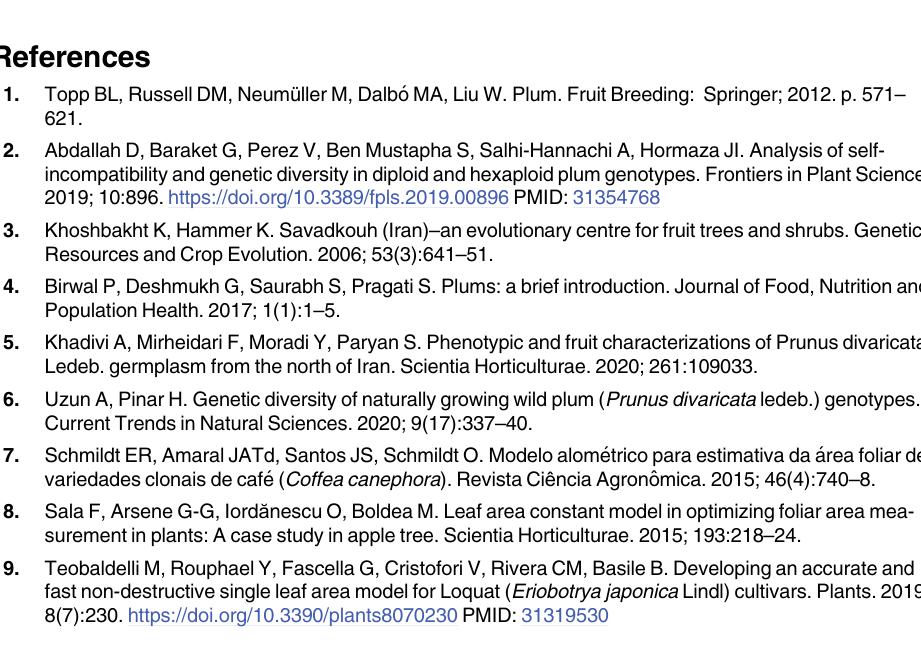
S4 Table. Experimental leaf length, width and area values of Shahryari greengage genotype in 2021. S5 Table. Experimental leaf length, width and area values of Jangali myrobalan plum in